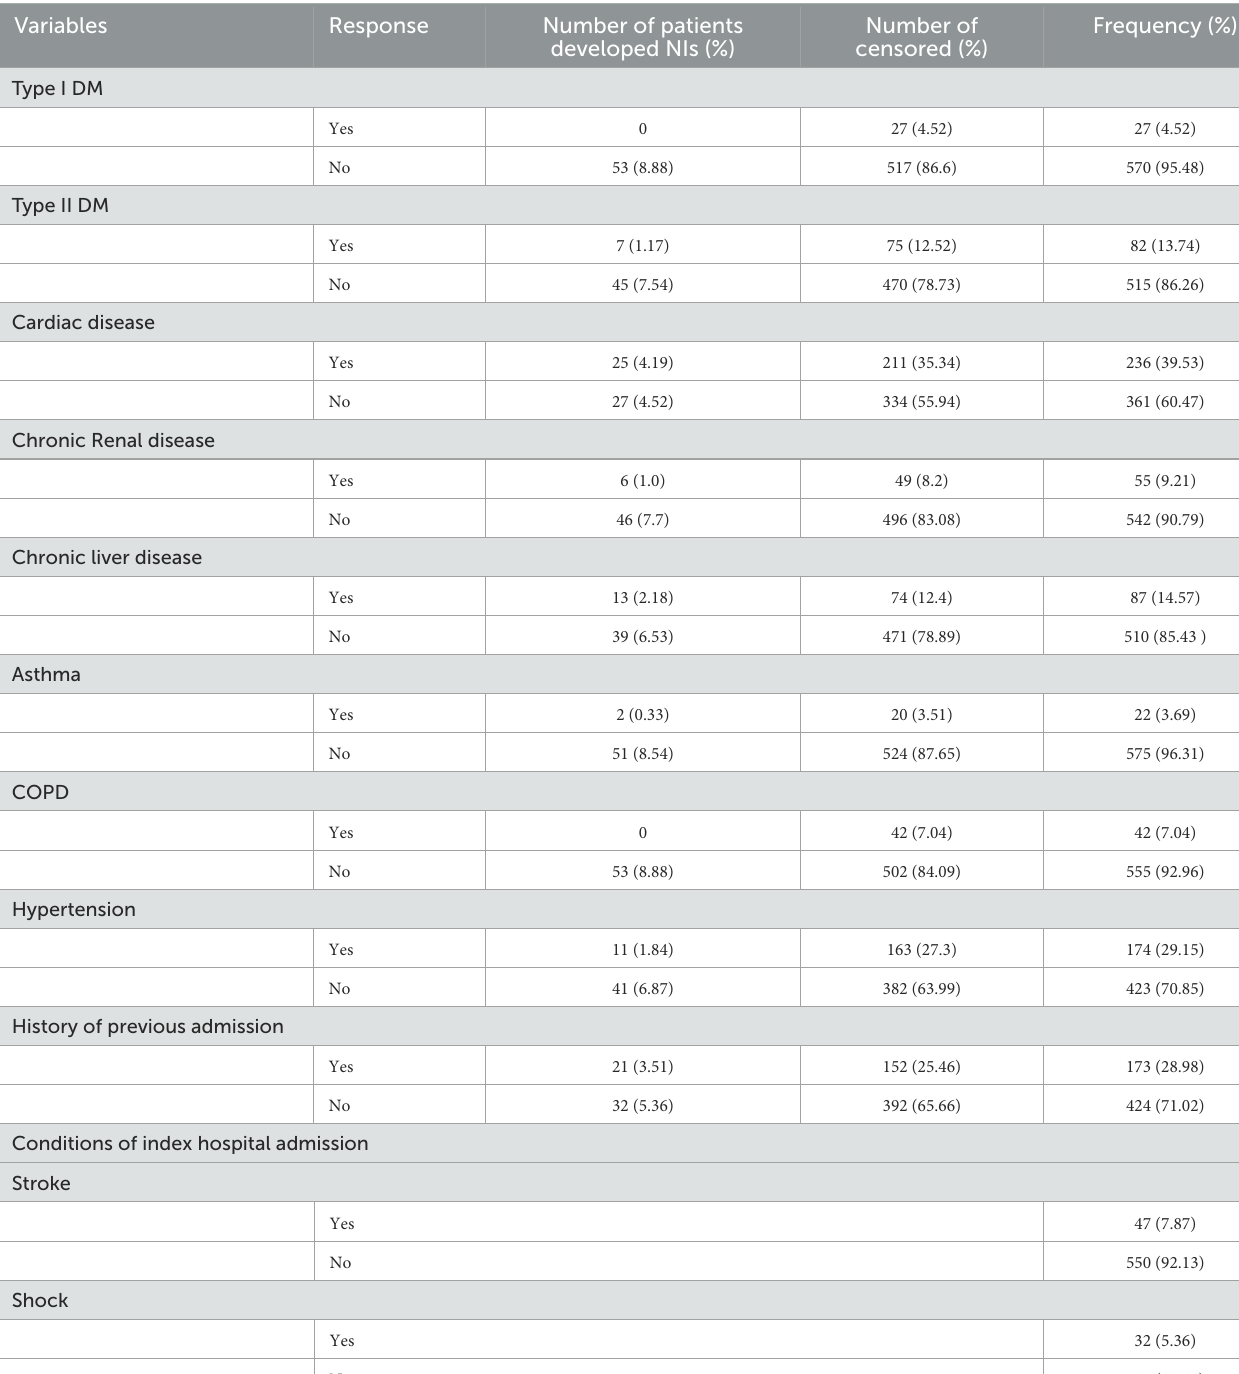
TABLE 2 Clinical factors among adult chronic illness patients admitted at the University of Gondar Comprehensive Specialized Hospital, Northwest Ethiopia, 2016–2020 ( N =